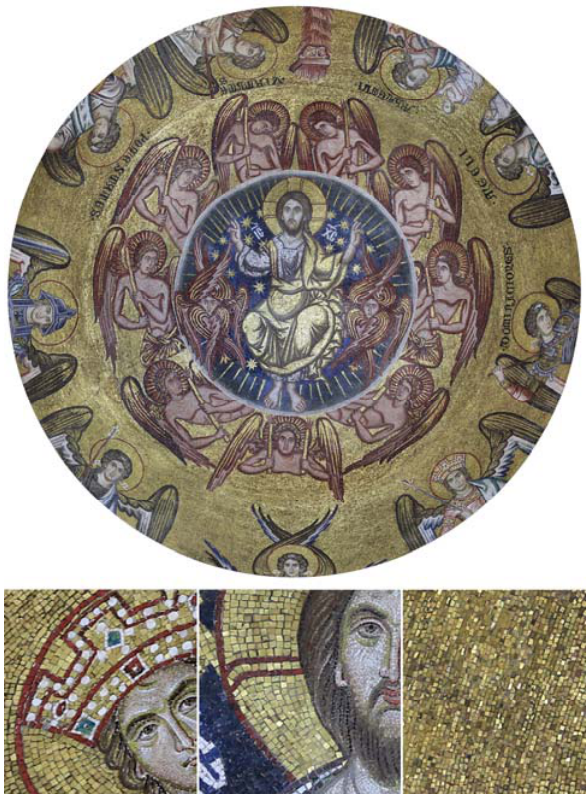
Figure 7: orthophoto of the dome of Baptistery with a detail 0.0005 m for